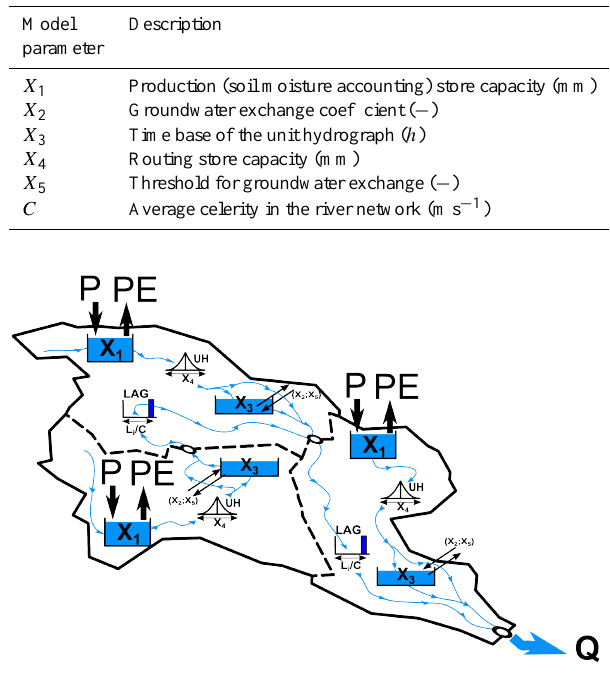
Fig. 3. Schematic representation of the semidistributed version of the GR5H rainfall–runoff